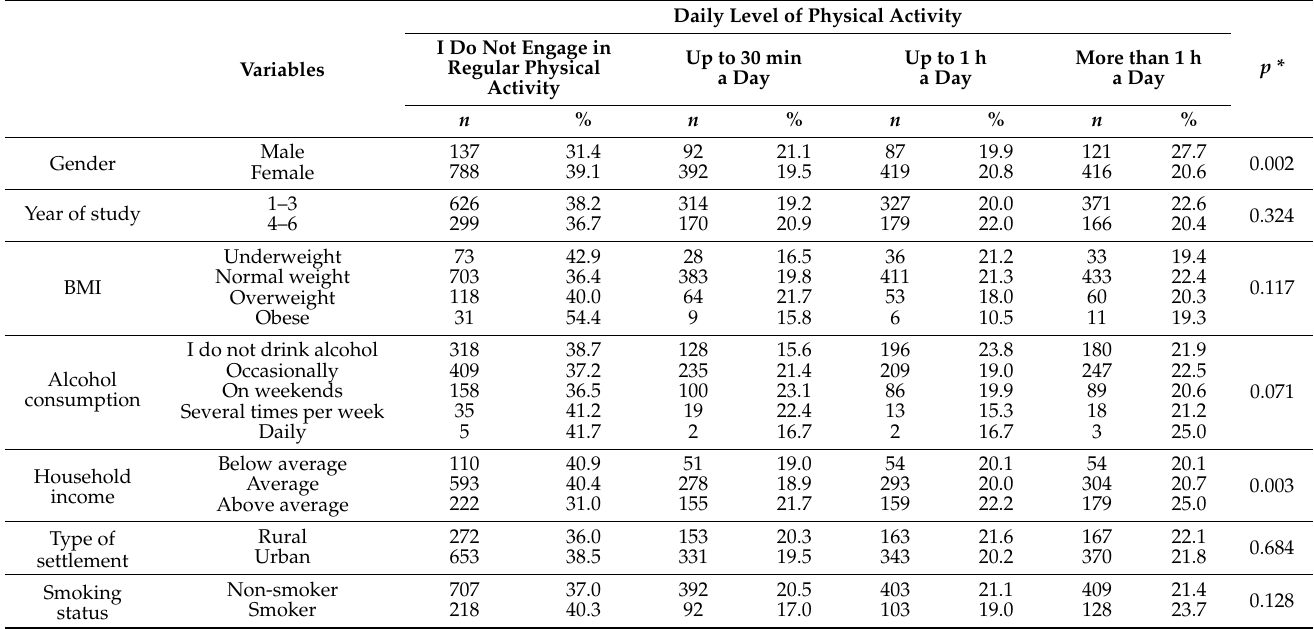
Table 6. Daily level of physical activity according to gender, year of study, body mass index (BMI), alcohol consumption, household income, type of settlement and student smoking status.